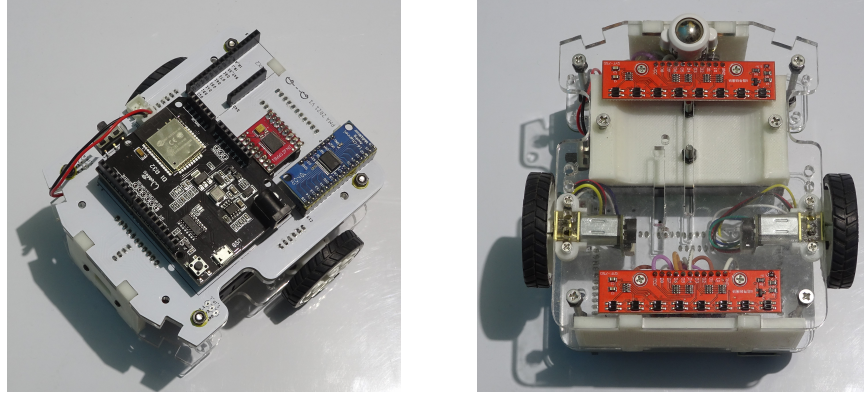
Figure 4. Top and bottom views for a single assembled